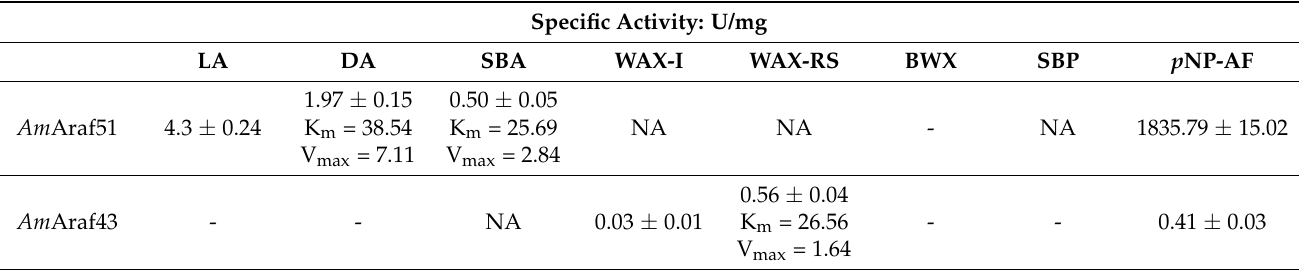
Table 1. Specific activities and kinetic parameters of Am Araf51 and Am Araf43 on different substrates. Specific Activity: